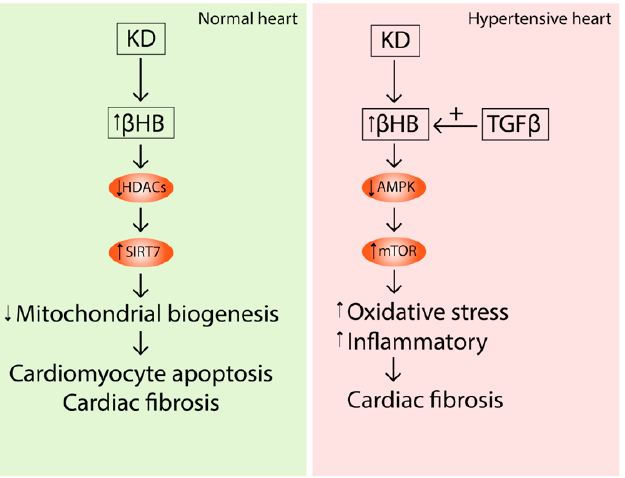
Figure 5. Long-term effects of KD and increased levels of β HB in normal and hypertensive hearts. β HB inhibits the HDAC2 that activates Sirt7 transcription leading to cardiomyocyte apoptosis and cardiac fibrosis in wild-type rats. In hypertensive hearts, KBs inhibit AMPK signaling, activate mTOR and result in cardiac fibrosis. This effect can be stimulated by TGF- β . ( ↑) Activation; ( ↓) Inhibition.